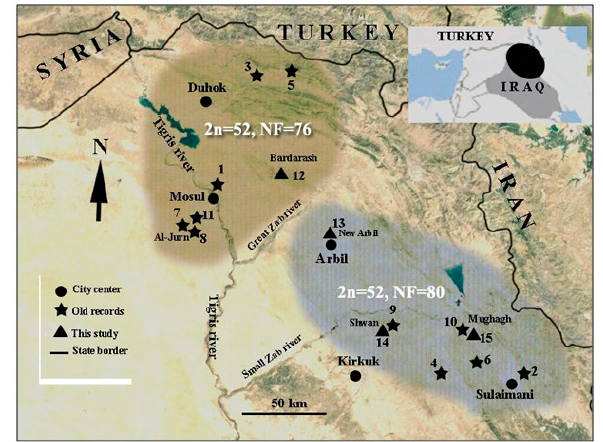
Figure 1. Sampling localities and geographical distribution of chromosomal forms of Nannospalax ehrenbergi in the Kurdis- tan region-Iraq ( ∗ : Old records) 1- Near Mosul (Cheesman 1920); 2- Near Sulaimania (Bate 1930); 3- Sarsank (Hatt 1959); 4- Jarmo, Chemchamal Valley (Reed 1958); 5- Ser ‘Amadia and Tinn (Har- rison 1956); 6- Jarmo, Palegawra Cave (Turnbull and Reed 1974); 7-Al-Jurn (Coşkun et al. 2012); 8- Al-Jurn (Coşkun et al. 2014); 9- Kirkuk-Shwan (Coşkun et al. 2014);10- Sulaimania- Mughagh (Coşkun et al. 2014); 11- Al-Jurn (Coşkun et al. 2016); ( ▲ : This study) 12- Duhok-Bardarash; 13- Arbil-New Arbil; 14- Kirkuk- Shwan; 15- Sulaimania-